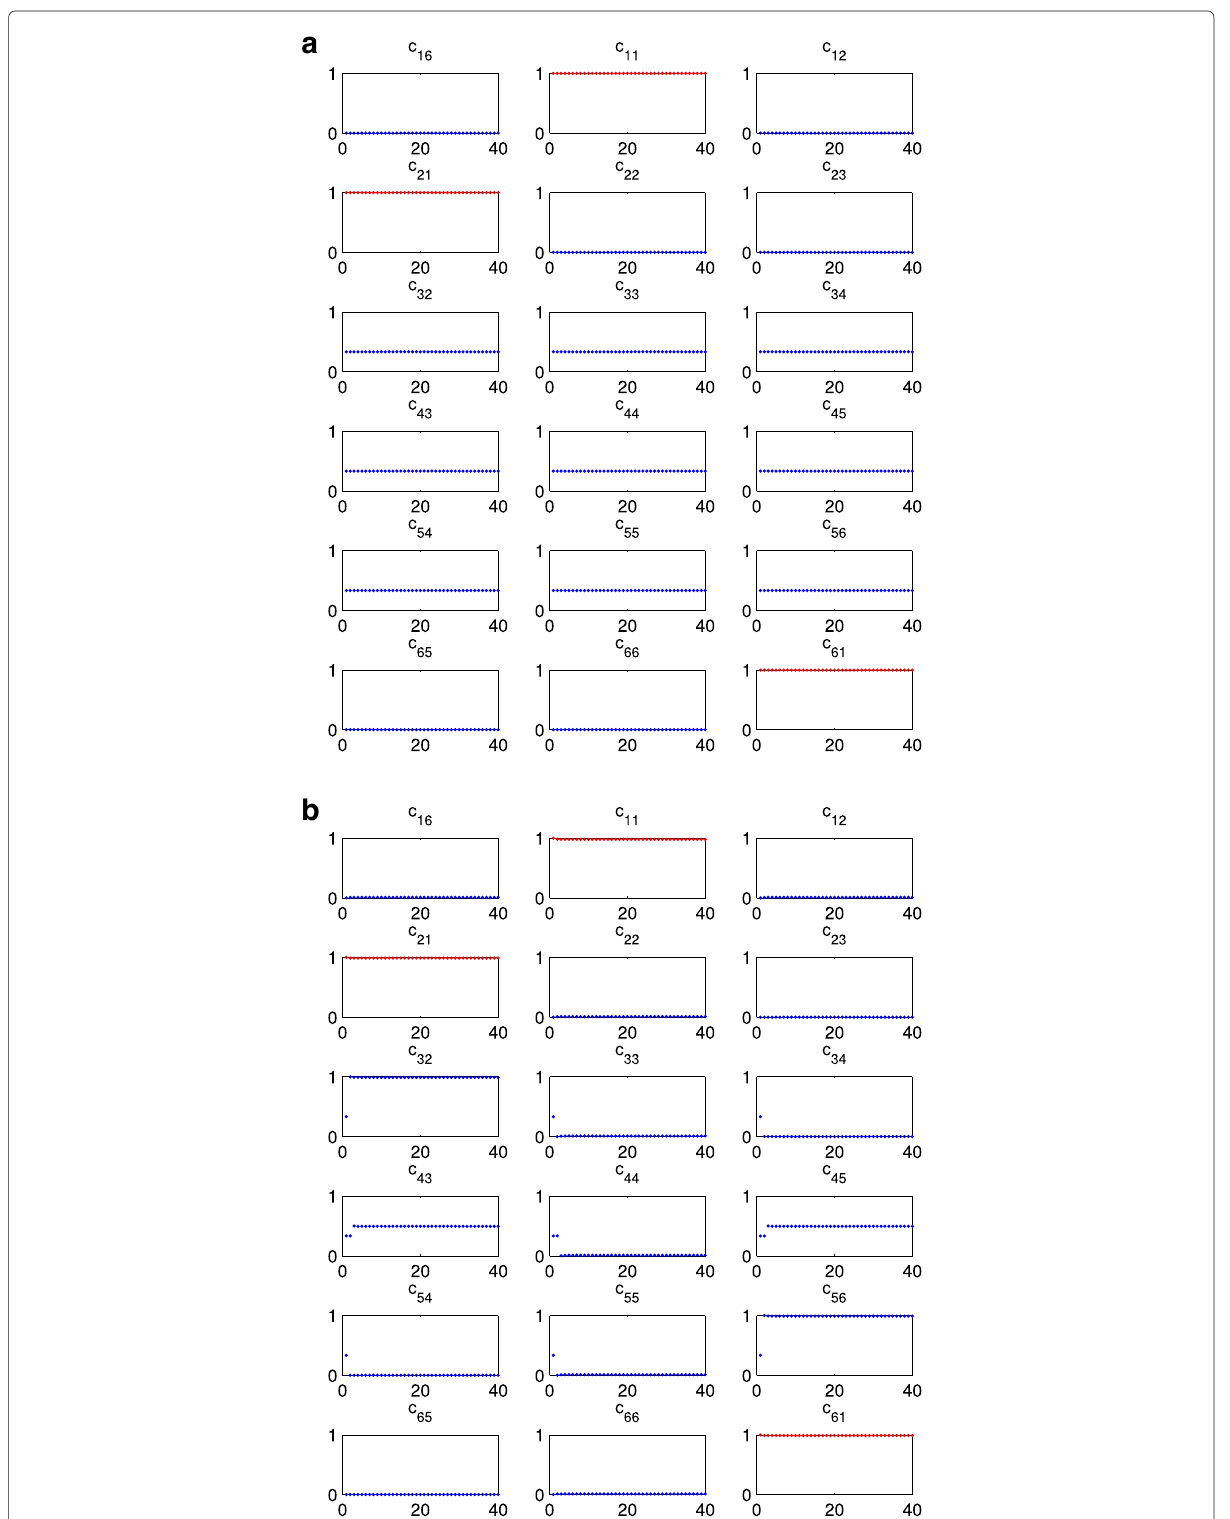
Fig. 2 Time evolution of the nonzero consensus weights. Weights corresponding to the measuring node are shown in red. a The original adaptation procedure